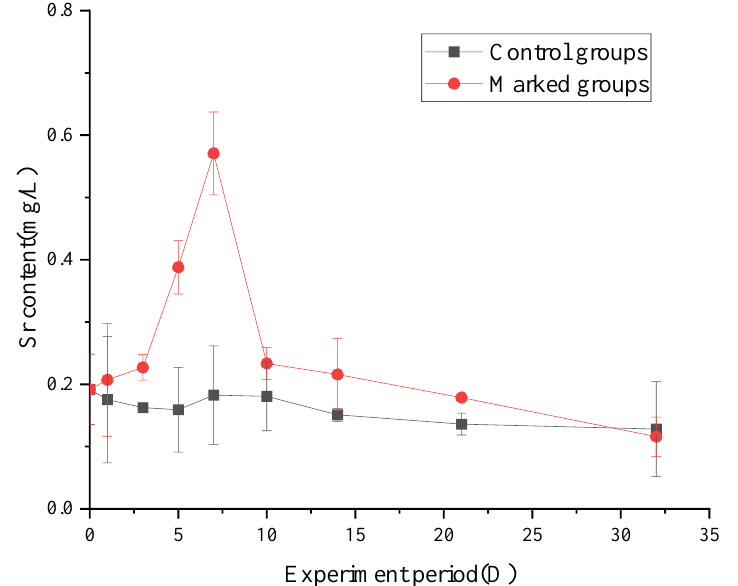
2+ in liver of T. obscurus